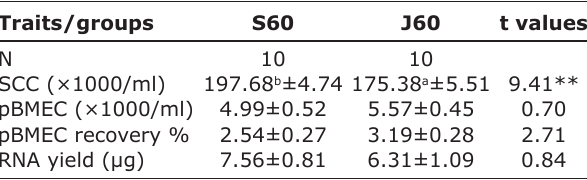
Table-3: Mean somatic cells, pBMECs and RNA yield among different groups.